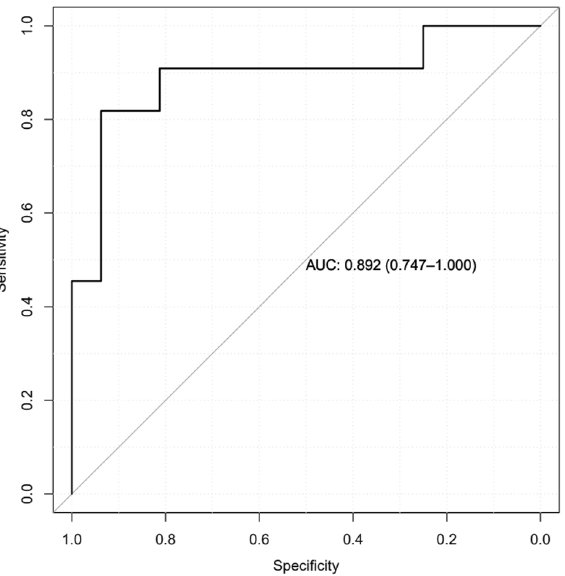
Figure 3. Receiver operating characteristic (ROC) curve to predict the response to infliximab therapy in patients with pediatric inflammatory bowel disease at baseline. The bacterial genus Ruminococcus and baseline fecal calprotectin values were included in the model. The area under curve (AUC) is